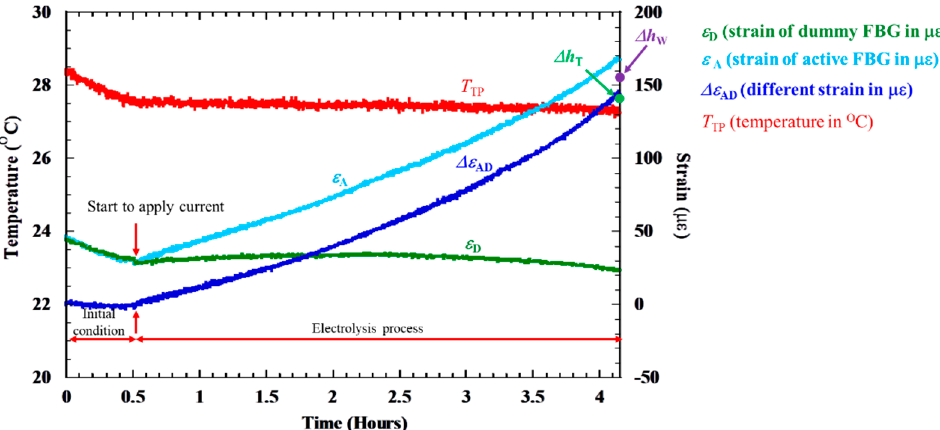
Figure 11. Strains measured during the electrolysis process. Equivalent strain from the actual change in thickness ( ∆ h T ) and change in thickness evaluated from weight loss ( ∆ h W ) are labeled on the plot for comparison.